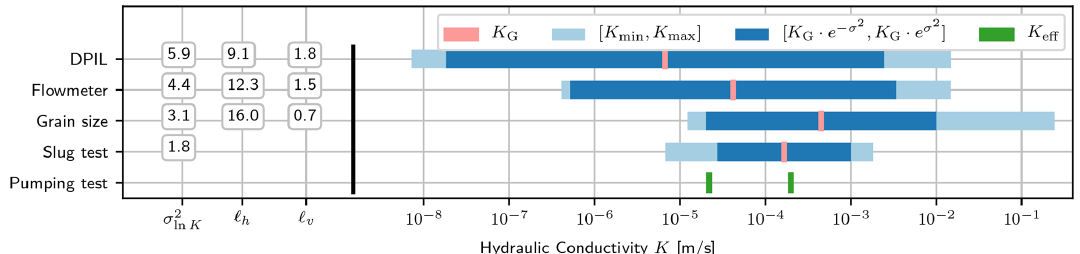
Figure 4. Geostatistical values for MADE from DPIL (direct push injection logging) (Bohling et al., 2016), flowmeters, grain size analysis, slug tests (Rehfeldt et al., 1992), and effective mean values ( K eff ) of two large-scale pumping tests (Boggs et al., 1990): log-conductivity variance σ 2 and horizontal and vertical correlation length (cid:96) h and (cid:96) v , respectively. Visualization of the range of observed values from ln K minimal ( K min ) to maximal ( K max ), variance range, and geometric mean K G